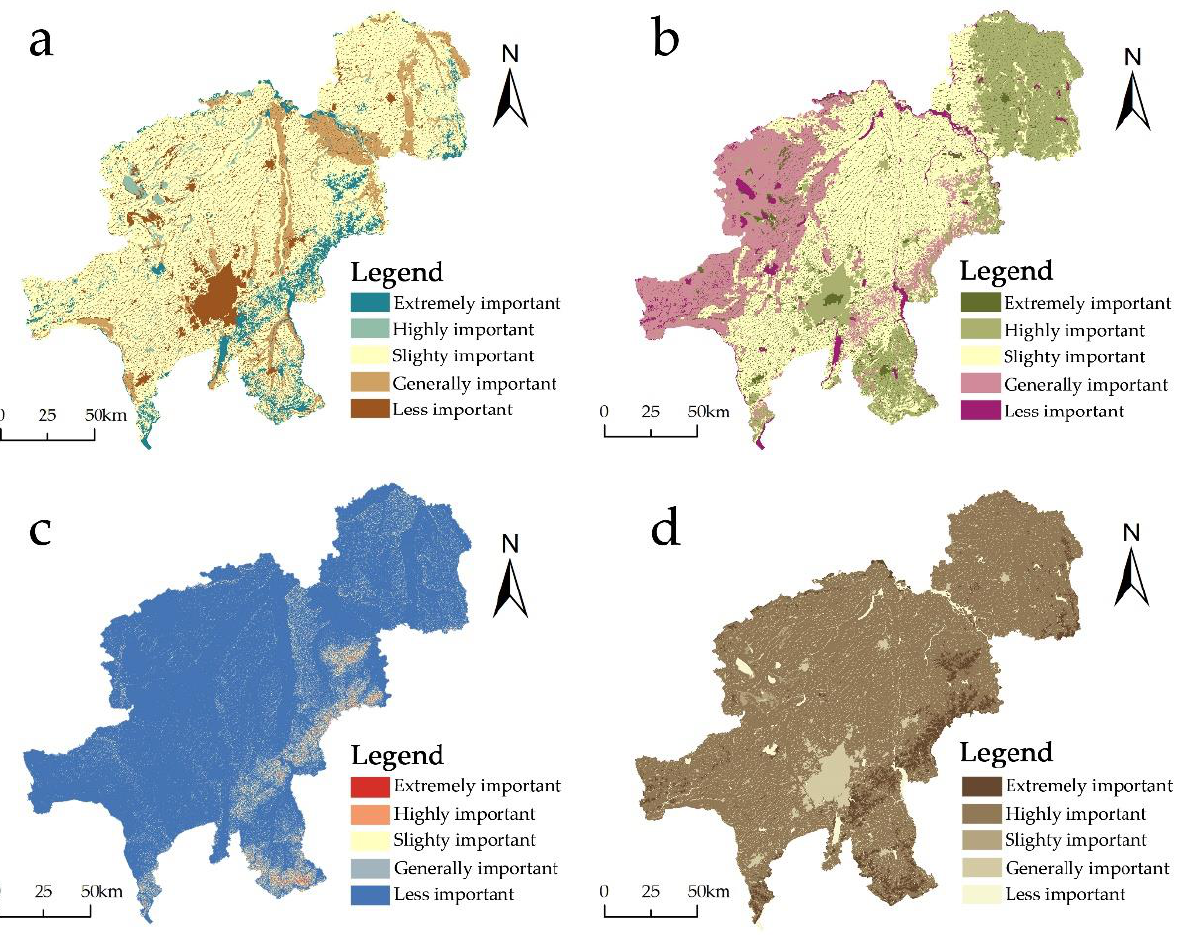
Figure 2. Four types of ecosystem service importance levels. ( a ) Biodiversity importance rating. ( b ) Water production importance rating. ( c ) Soil conservation importance rating. ( d ) Carbon fixation importance rating.